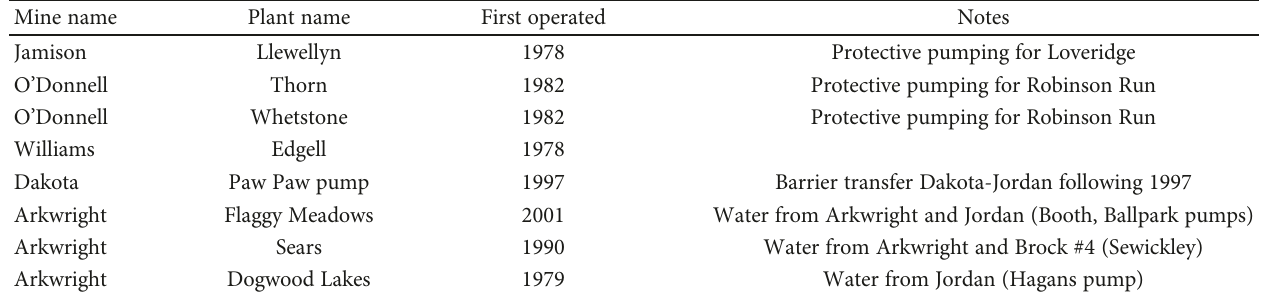
Table 3: Currently active treatment plants handling Fairmont Coal fi eld mine water. See Figure 4 for locations.